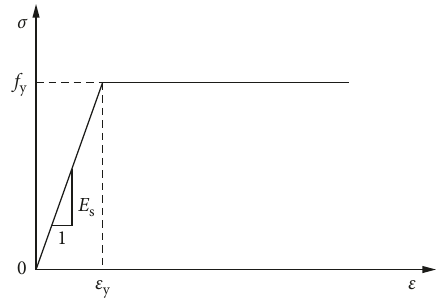
Figure 10: Steel constitutive